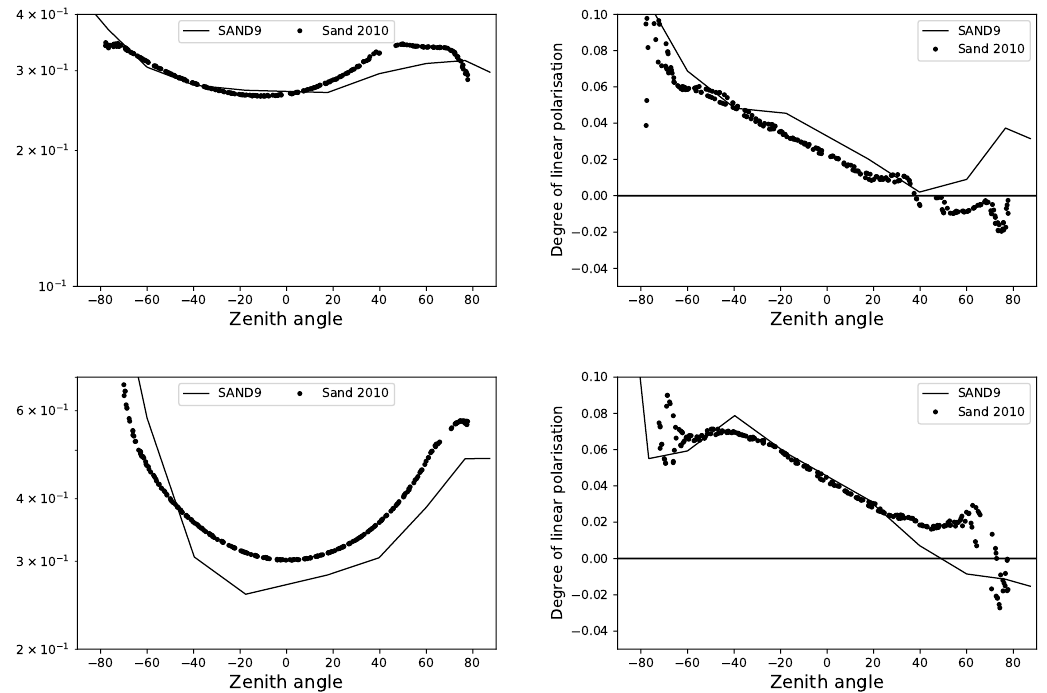
Figure 4. The modelled BRF (left) and DQP (right) of common beach sand (line) compared with experimental data (dots). The angle of incidence is 43 ◦ on top, and 68 ◦ in the middle, and 57 ◦ on the